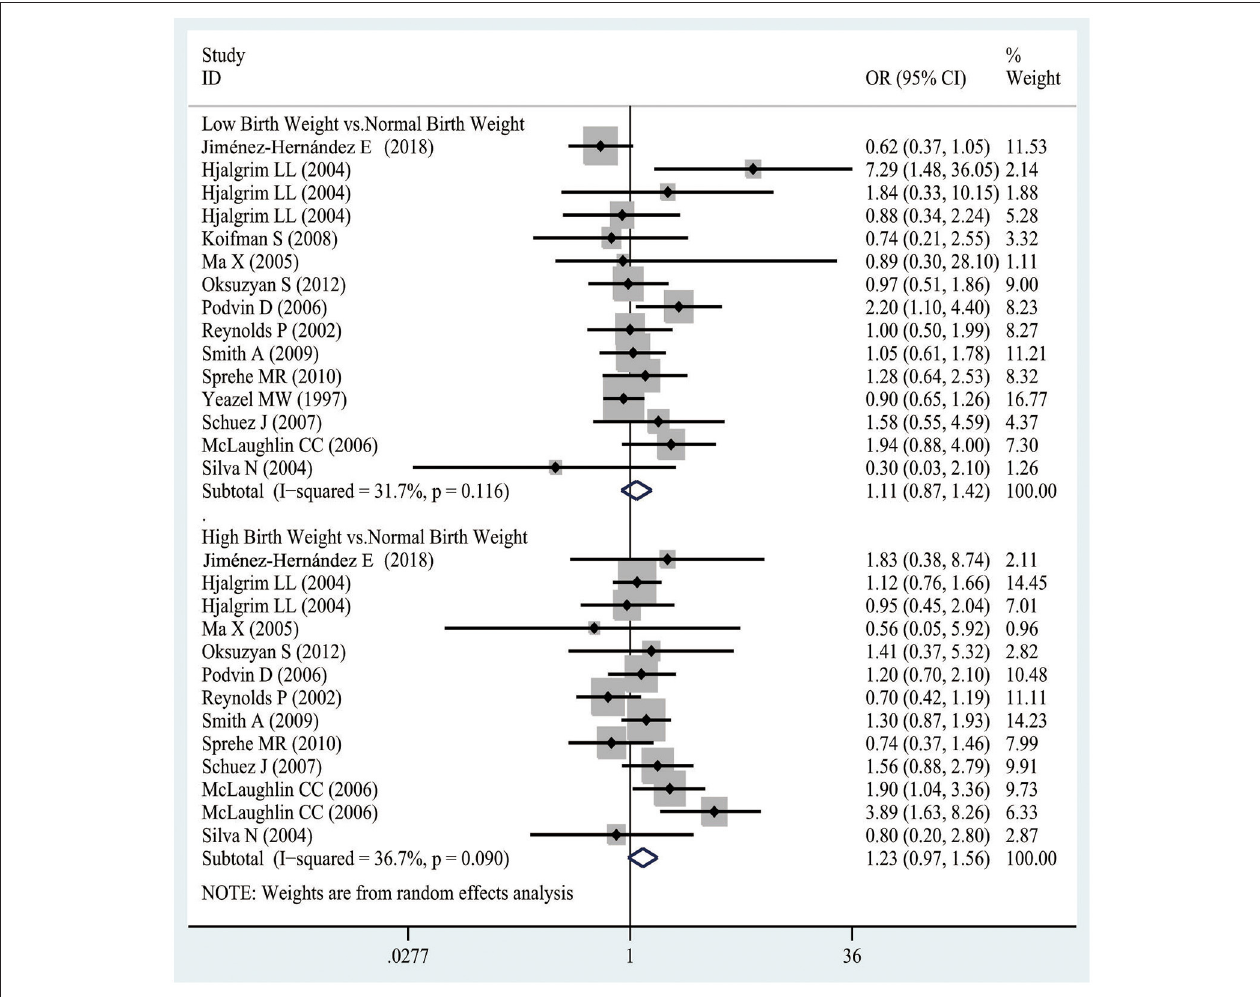
FIGURE 4 | The odds ratios for low birth weight, high birth weight, and